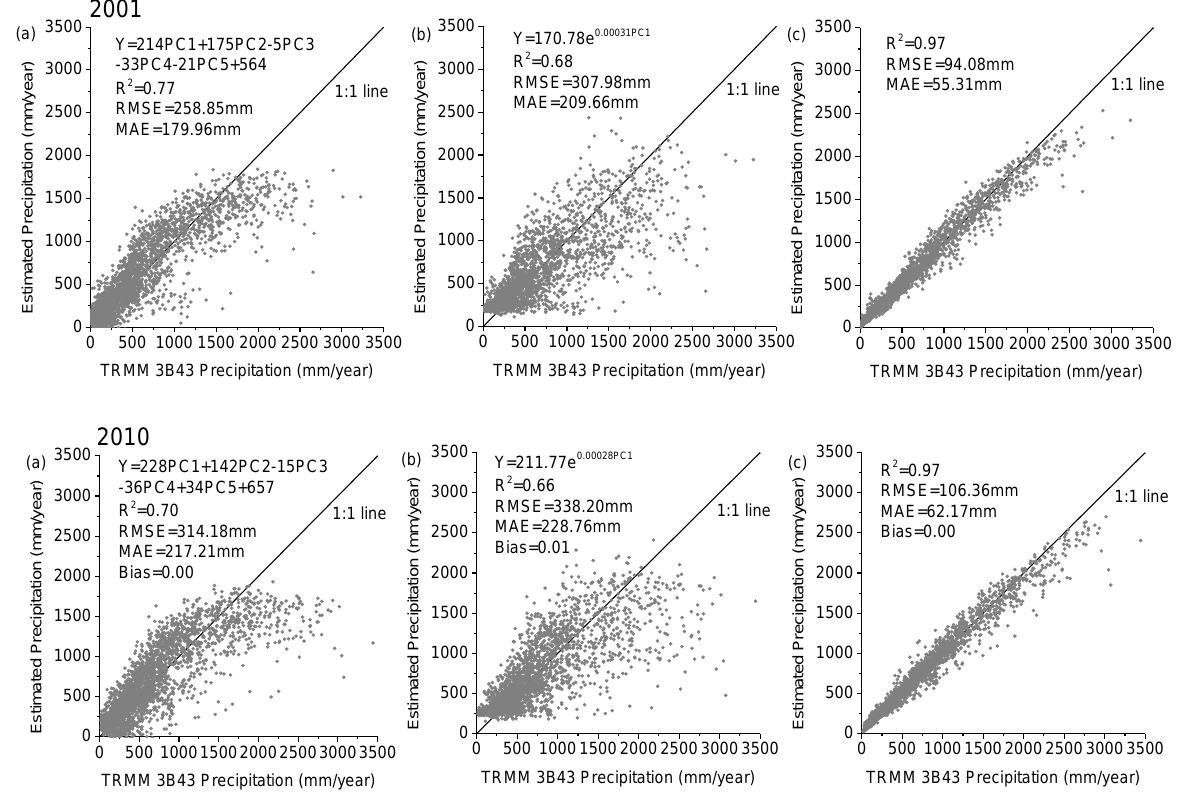
Figure 3, the RF model performed best in terms of the R 2 , RMSE, and MAE in 2001 and 2010, when compared to the two previous models.